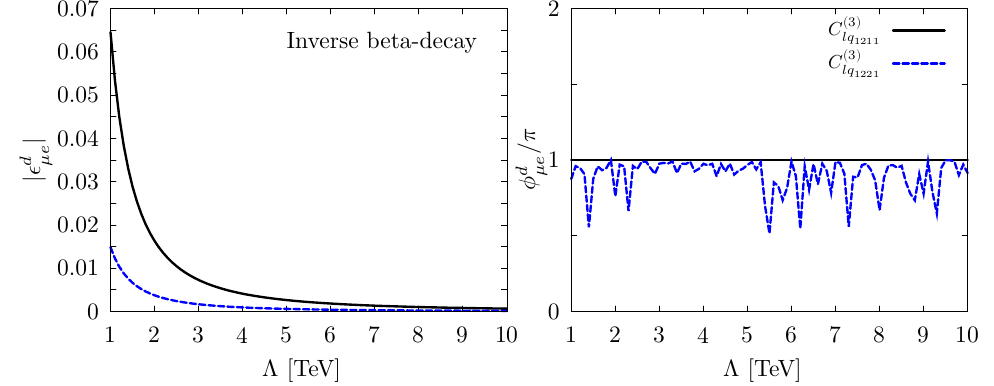
Figure 14 . The magnitude and phase of the detection NSI parameter (cid:15) d where detection is based on inverse beta decay. As an example, the values acquired for the NSI parameter are presented for one CP -conserving operator (solid black) and one CP -violating operator (dashed blue) as function of the UV-scale Λ